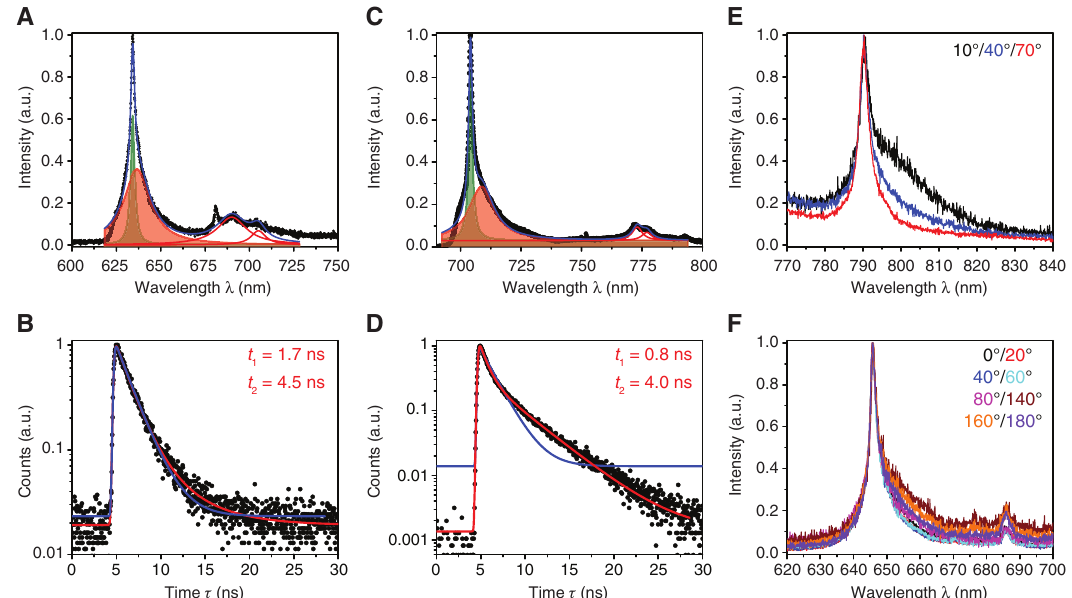
Figure 5: Photoluminescence spectra, fluorescence lifetime measurements and polarization-dependent emission from individual defects in hBN. (A, C) Spectra of two typical emitters in hBN. The solid, colored lines are Lorentzian fits to the data. (B, D) Lifetime measurements on the emitters shown in A and C. The solid lines are fits according to a mono-exponential (blue) and bi-exponential (red) decay including the instrument response function of the setup. Both measurements follow a bi-exponential decay with time constants t = 1.7 ns, t = 4.5 ns. (E, F) Polarization-dependent optical spectra of two typical hBN emitters in emission. The line shape strongly depends t 1 2 on the angle of a polarizer in the detection